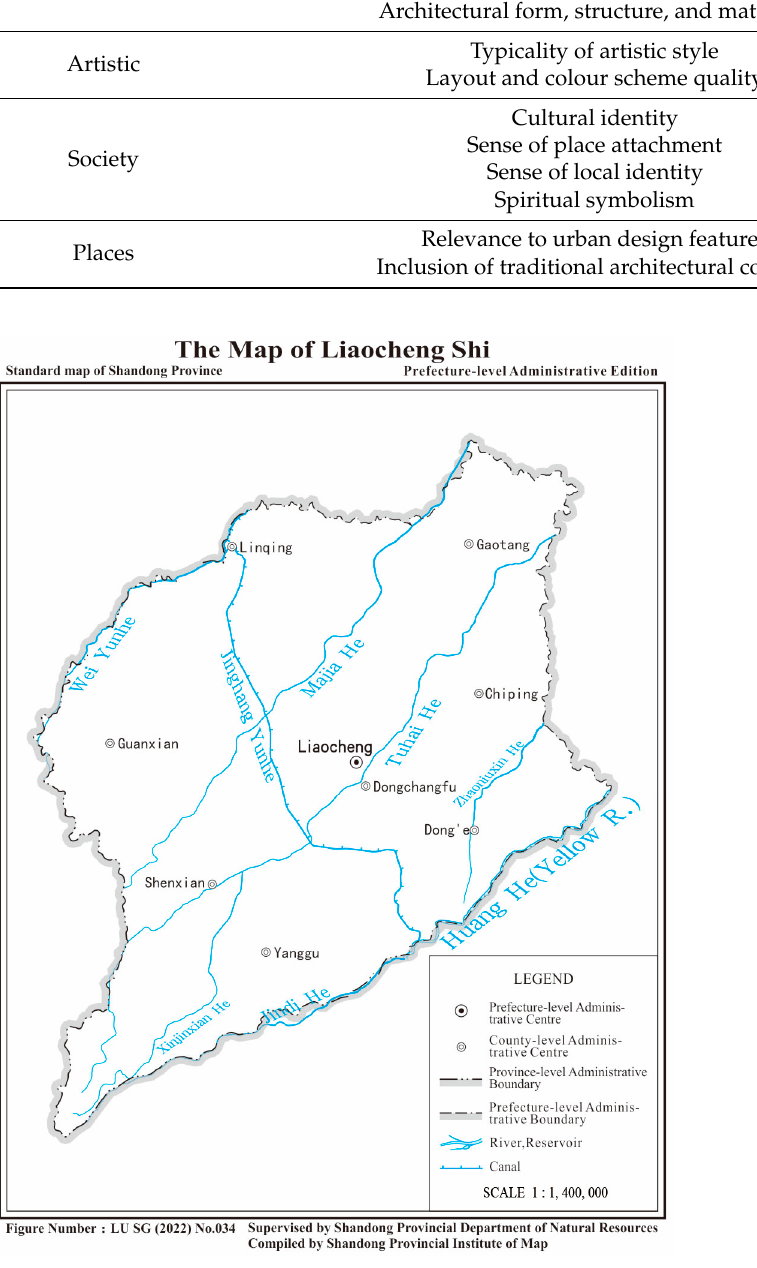
Figure 4. Location of the case building in Liaocheng City, Shandong Province (figure supervised by Shandong Provincial Department of Natural Resources Compiled by Shandong Provincial Institute of Map; Approval Number: LU SG (2022) No.